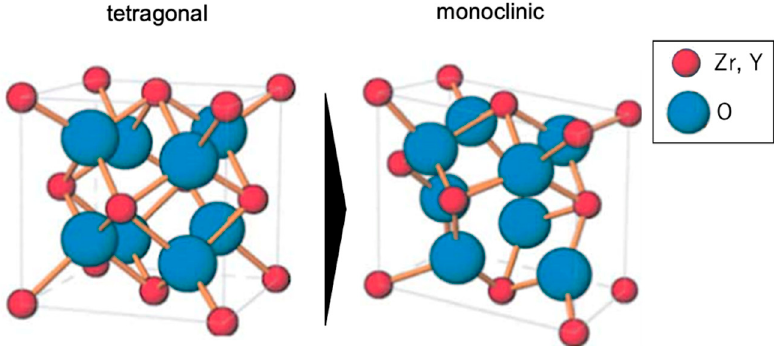
Figure 6. Crystal structure of monoclinic and tetragonal partially stabilized zirconia [24].